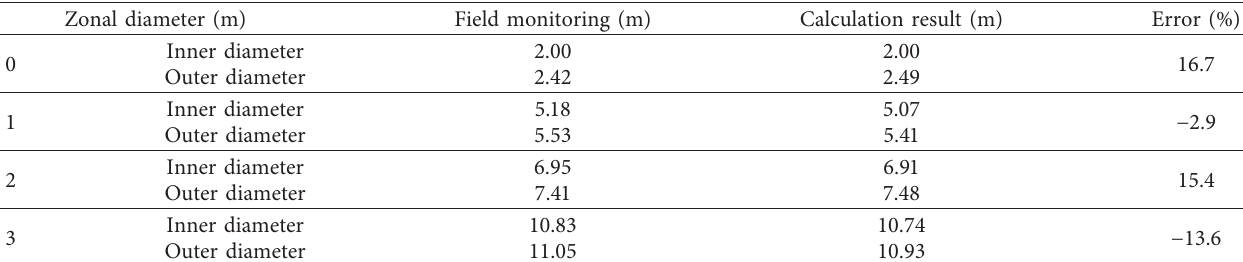
Table 6: Comparison of theoretical calculation and field measurement of zonal disintegration in Qinling water diversion tunnel. Zonal diameter (m)